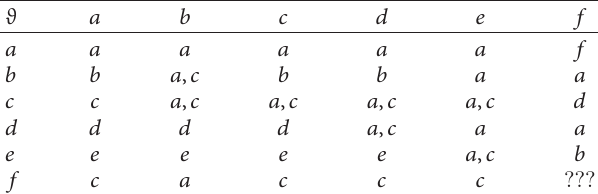
Table 4: Neutro hyper BCK-algebra of an economic network.